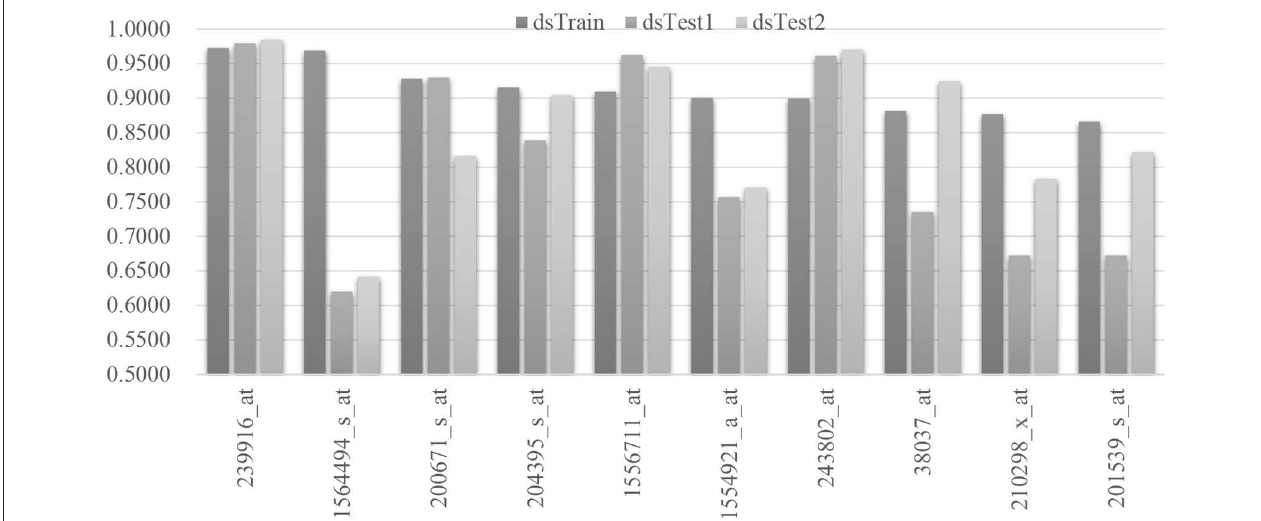
FIGURE 3 | Pearson correlation coefficients of the regression performances of the 10 mqTrans features. We select the top 10 mqTrans features with the largest Pearson correlation coefficients on the hold-out testing dataset. The regression model of each mqTrans feature is evaluated for its regression performances in the control samples in the three datasets dsTrain, dsTest1 and